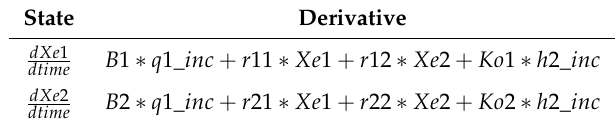
Table 4. ODE page of the control through observed state feedback (SISO